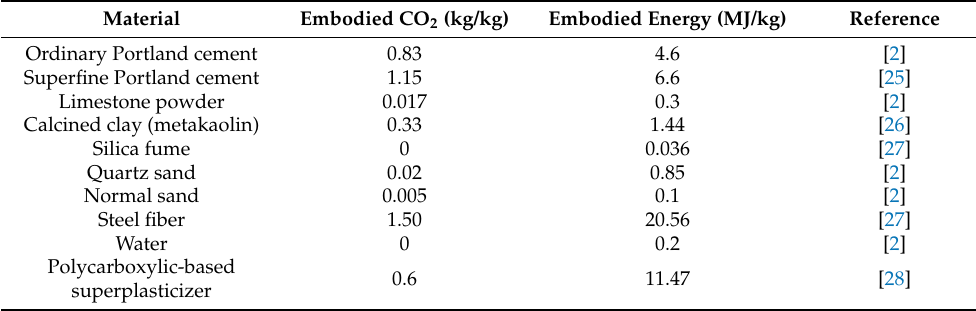
Table 2. Embodied CO 2 and energy for raw materials used in this